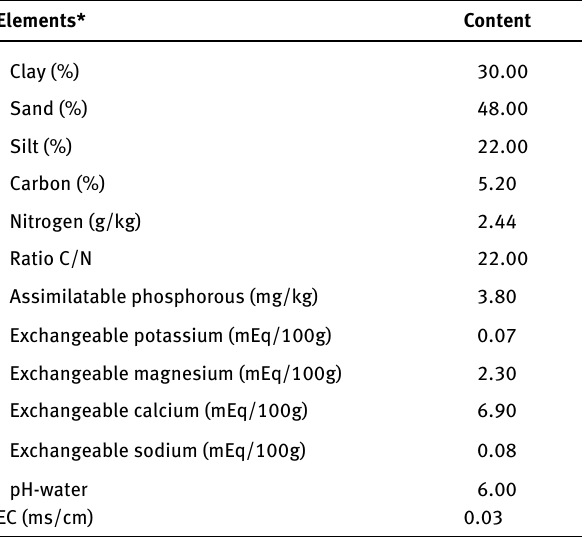
Table 1: Chemical and physical characteristics of the soil (0-20